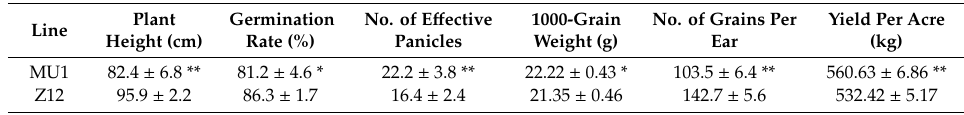
Figure 1. Diagrammatic illustration of the repeated pollination approach and analysis of phenotypic traits of the a morphologically stable line MU1. ( A ) Repeated pollination approach [28] used to generate a morphologically stable line. 1: Remove anthers; 2: Cut half of each flowering glume; 3: Intergenic pollination. ( B ) MU1 and Z12 (wild type) plants at the tillering stage and their seeds with/without husks. ( C ) Plant height of MU1 and Z12 plants at the heading stage. ( D ) Grain weight per plant. Plants of MU1 and Z12 were grown in the greenhouse. Data represent mean ± standard deviation (SD) of three biological replicates (n = 3), each comprising 20 plants. Significant differences between MU1 and Z12 are indicated with an asterisk (* p < 0.05; Student’s t -test). Table 1. Plant height, germination rate, panicle number, individual yield, and 1000-grain weight of MU1 and Z12 plants.